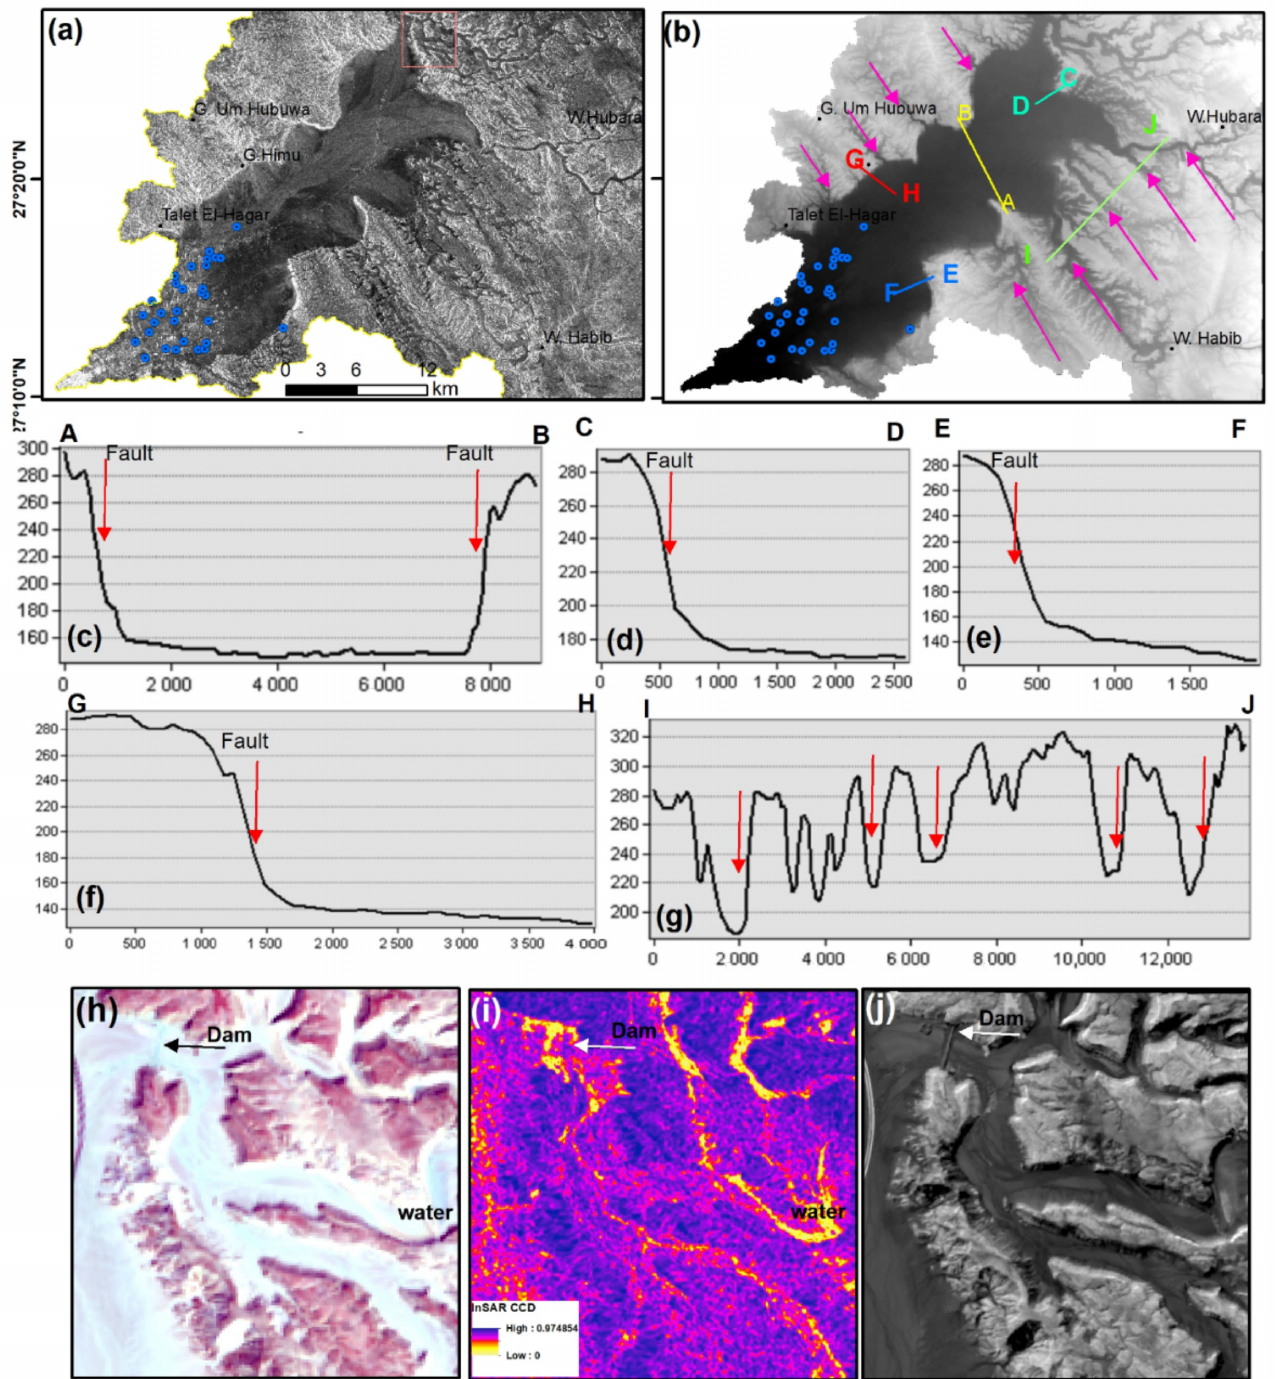
Figure 13. Downstream area of Wadi Asyuti: ( a ) AlOS/PALSAR covering the downstream area; the dark tone reveals the structurally controlled area that is overlaid by productive groundwater wells in blue; ( b ) DEM data are overlaid by topographic profiles; the pink arrows refer to the downstream direction of the wadis from NW to SE; ( c – g ) Topographical profiles A–B to I,J; ( h ) subset of OLI data showing the dam site and the signature of the water in cyan; ( i ) the InSAR CCD data for February 2015–February 2017 reveal the changes in yellow, representing the flood zone; ( j ) PC1 of the 2022 Sentinel-2 data displays the dam site and